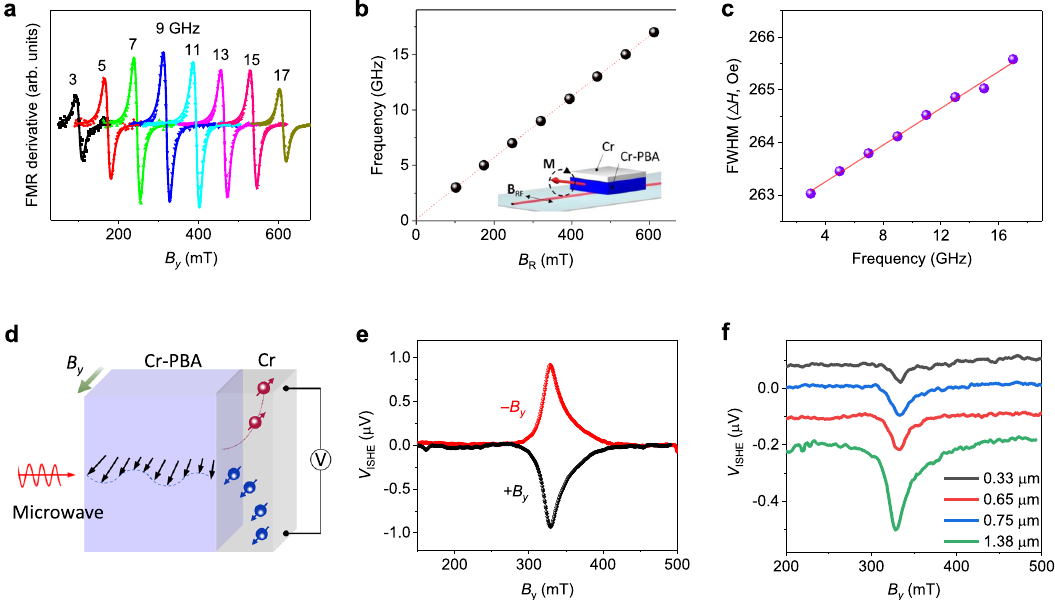
Fig. 4 FMR and FMR-driven ISHE results for Cr-PBA/Cr heterojunctions. a First derivative FMR spectra of the Cr-PBA (1.4 μ m)/Cr (10 nm) heterojunction at various microwave frequencies measured at 100 K. The recorded data are fi tted by using the derivative of the Lorentzian function. b Frequency dependence of resonance fi eld B R . Fitting with the Kittel equation produces M s = 12.676kA/m and g -factor = 1.96. c FWHM as increasing the frequency of r.f. fi eld. The slope of a linear fi t produces a low effective Gilbert damping constant, α eff ~ 7.5 × 10 − 4 . d A schematic illustration of the spin pumping from microwave driven magnon propagation in the Cr-PBA fi lm and its conversion into an electrical current in the Cr layer via ISHE. e V ISHE ( B ) measured for the Cr-PBA (1.4 μ m)/Cr (10 nm) bilayer upon applying 9 GHz of microwave. f V ISHE ( B ) of Cr-PBA/Cr heterojunctions with various Cr-PBA